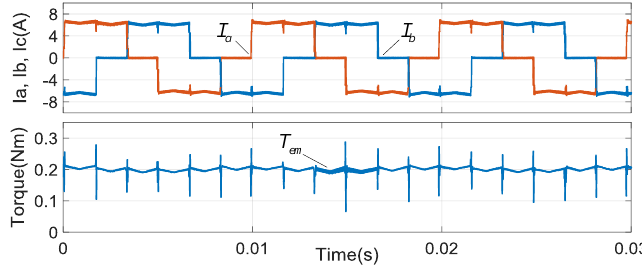
Figure 10. Test waveforms at the speed of 3000 r/min with SWC.